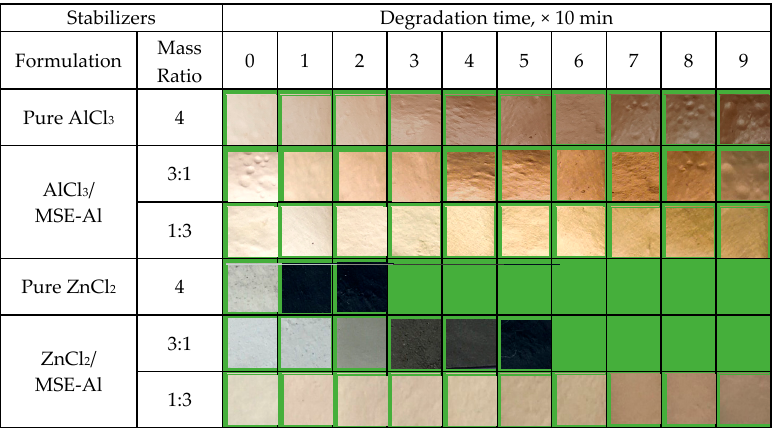
Figure 11. Thermal aging test of PVC samples compounded with different stabilizers and heated at 180 °C.